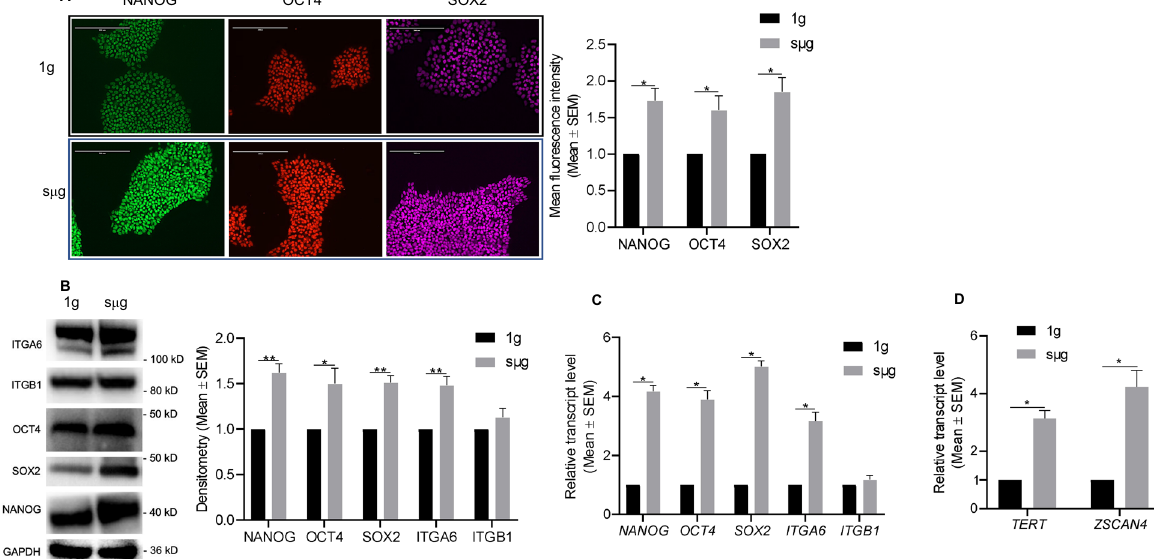
Fig. 2 Simulated microgravity (s μ g) enhances the self-renewal of hPSCs. Culture under s μ g maintained self-renewal of hPSCs and enhanced the expression of the core set of pluripotent transcription factors (TF), transmembrane glycoproteins ITGA6 and ITGB1, and telomere genes. A Representative immuno fl uorescent micrographs of colonies from s μ g and 1g conditions stained for the core set of pluripotent TFs. Scale bars, 200 µm. Graphs show the mean fl uorescence intensity analysis from micrographs. B Representative immunoblots and densitometry analysis from protein lysates of cells cultured at s μ g and 1g conditions. RT-qPCR analysis indicates relative mRNA levels of ( C ) pluripotent associated and ( D ) telomere elongation genes present in cells cultured at s μ g and 1g conditions. * p < 0.05, ** p < 0.005 ( n = 3; unpaired t test). Error bars in graphs represent the SEM of the